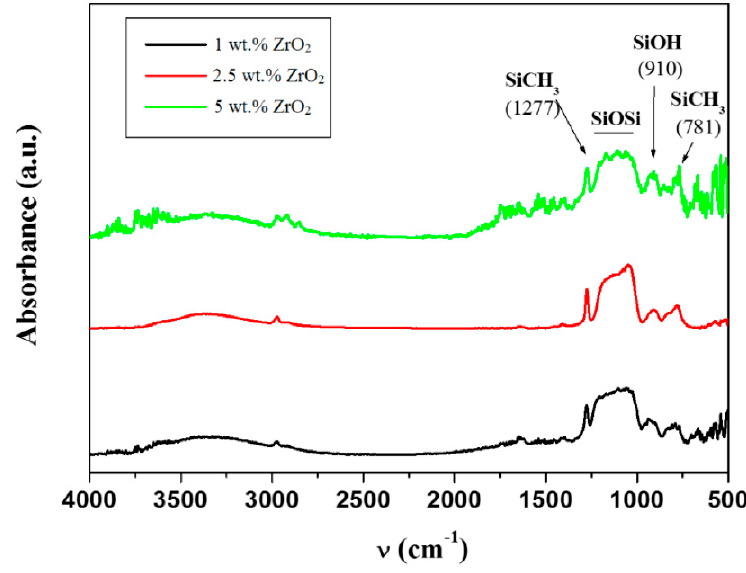
Figure 5. FTIR spectra of silane–ZrO 2 coatings.